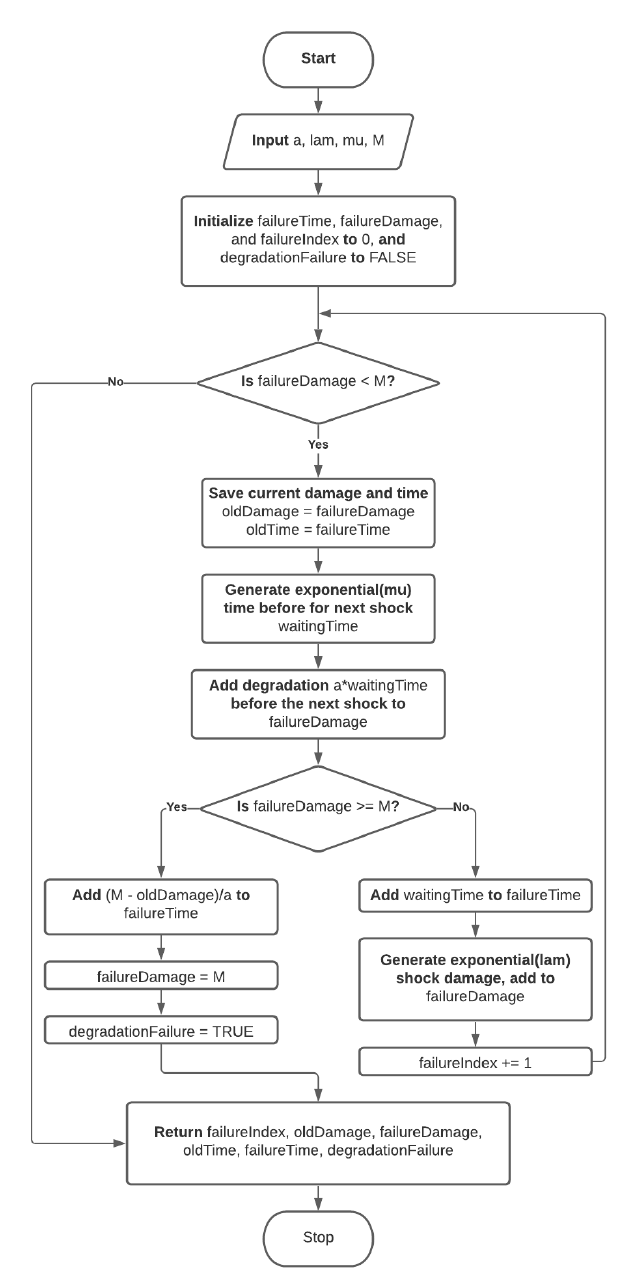
Figure A1. The simulatePath function accepts numerical inputs for each parameter of the process: a , λ , µ , and M . It then simulates one path of the process and returns sampled values of ν , A ν − 1 , S ν , t ν − 1 and τ ν along with a flag indicating whether a degradation failure or shock failure